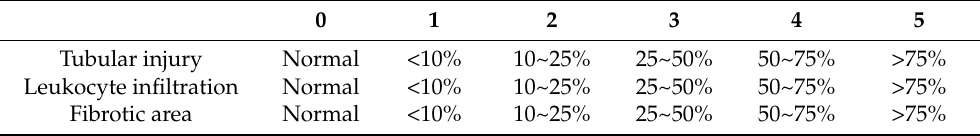
Table 1. Microscopy assessment of histological changes in UUO-induced renal